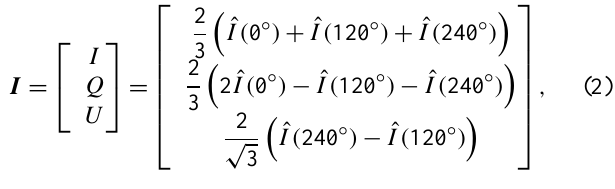
Figure 2 is an example of the typical polarization